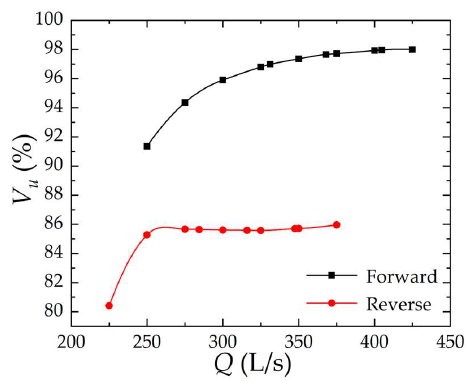
Figure 9. Uniformity of flow velocity at impeller inlet.